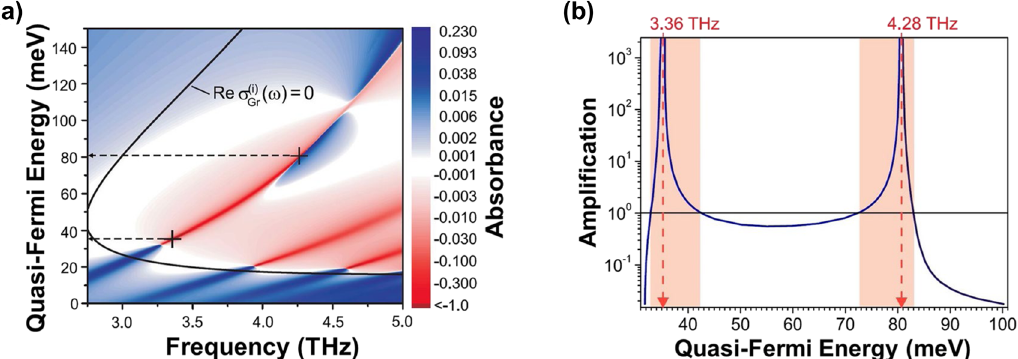
Figure 6: Impact of the plasmonic THz laser cavity in a DGG-GFET for a giant enhancement of resonant amplification gain. (a) Numerically simulated absorbance spectrum for the fundamental and higher-order GDPP resonances in the asymmetric DGG-GFET structure shown in Figure 5(b) as a function of the quasi-Fermi energy ϵ ′ F and the frequency of the incident THz wave. Adapted with permission fromref.[45].Copyright2017,AIPPublishingLtd.Solidblacklinecorrespondstothetransparentregimeoftheinvertedgraphene(therealpart of the conductivity is zero). The right (left) of this line is the ampli fi cation (attenuation) region where graphene works as a gain (loss) medium. The red lines are the routes for the GDPP resonant ampli fi cation modes (fundamental to the leftmost, and higher modes to the right). (b) The variation of the ampli fi cation coef fi cient along the lobe of the fundamental plasmon resonance in Figure 6(a) as a function of ϵ ′ F . Adapted with permission from ref. [45]. Copyright 2017, AIP Publishing Ltd. The values of ϵ ′ F marked by dashed arrows correspond to the self-excitation regime (plasmon lasing). In the colored regions, the ampli fi ed power exceeds that of the incident THz